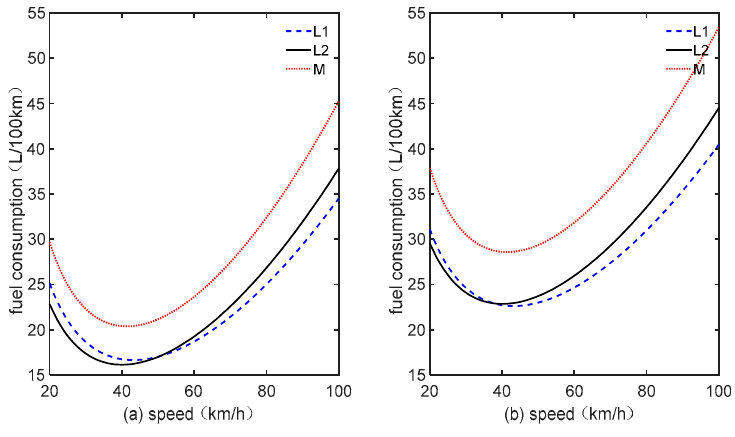
Figure 1. Fuel consumption as a function of speed.